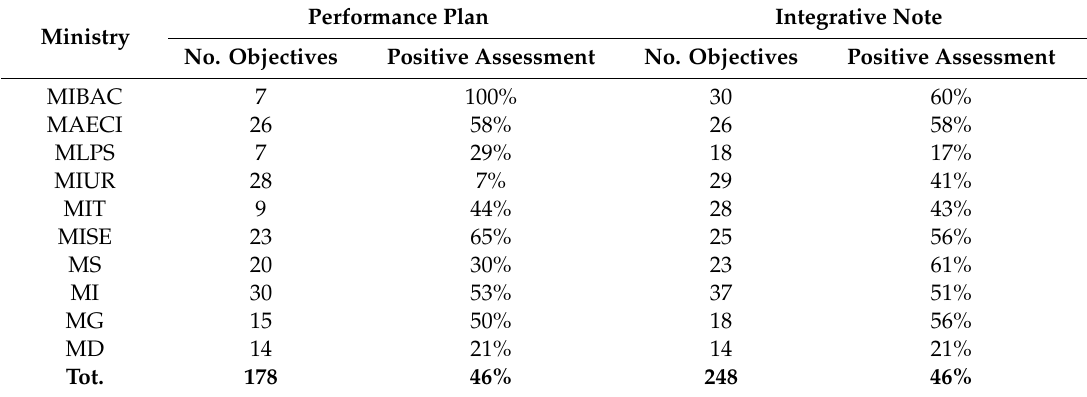
Table 3. Quality assessment (based on normative and SMART criteria) of objectives included in Performance Plans and Integrative